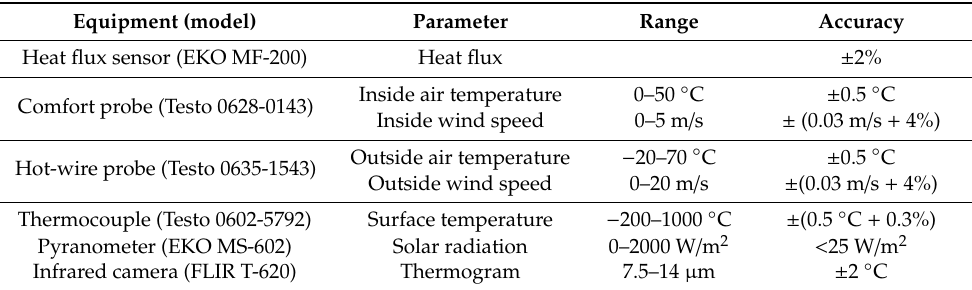
Table 2. Main technical specifications of measurement